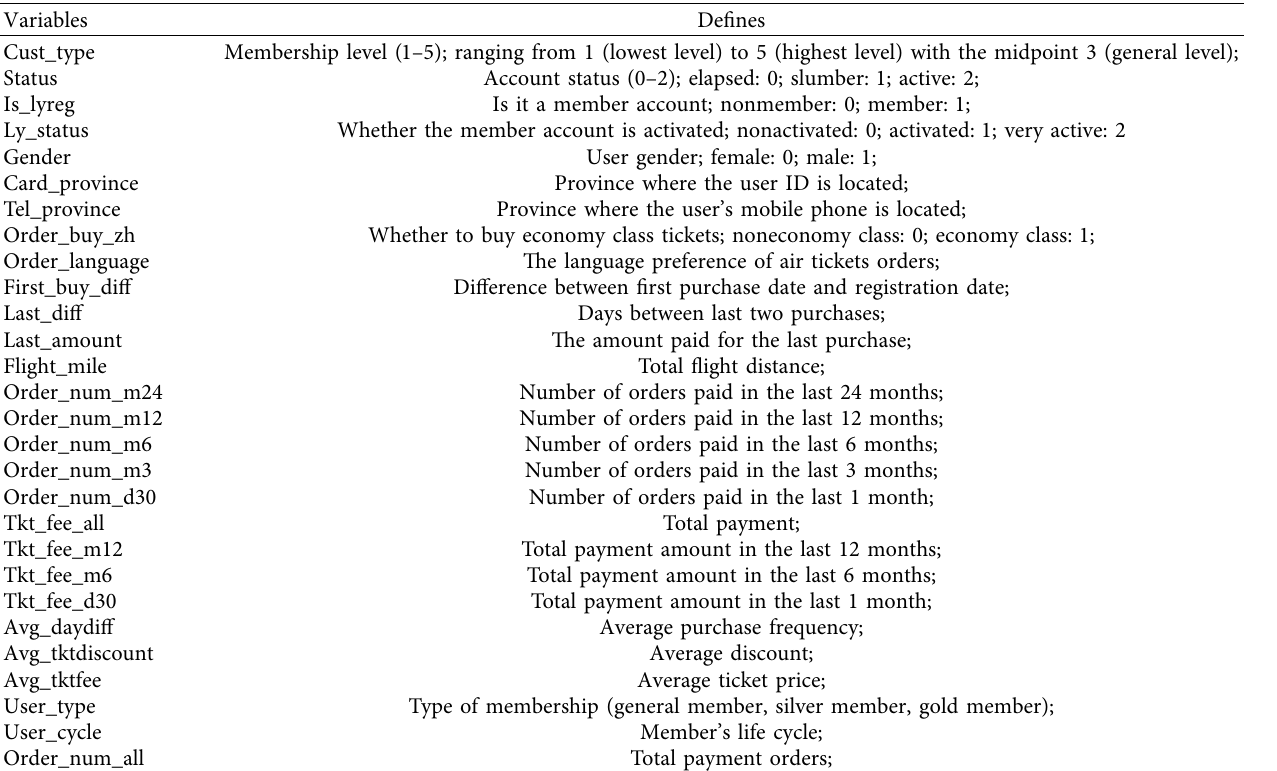
Figure 1: A framework for predicting traveler Table 1: The definitions of 28 feature variables.